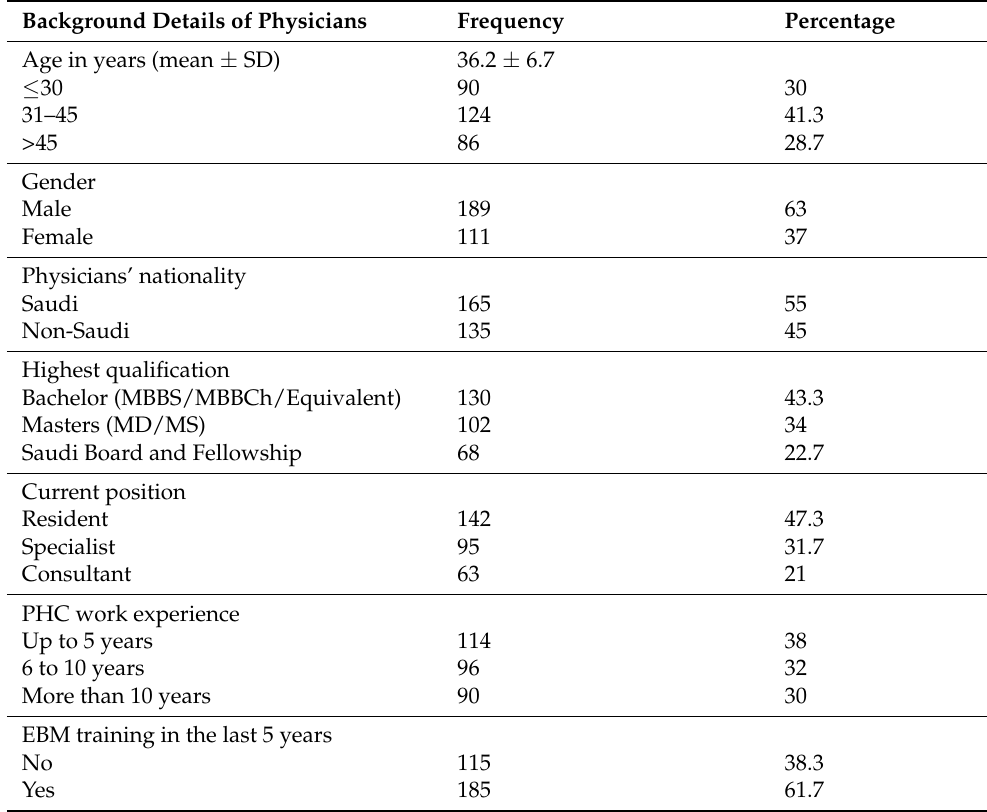
Table 1. Background details of study participants (n =